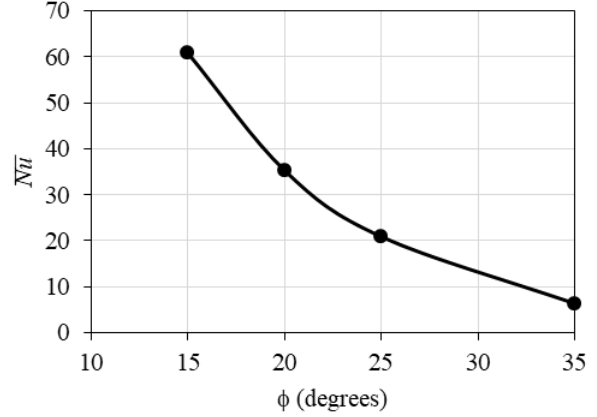
Fig. 11. Average Nusselt number of the hot base wall against roof pitch.